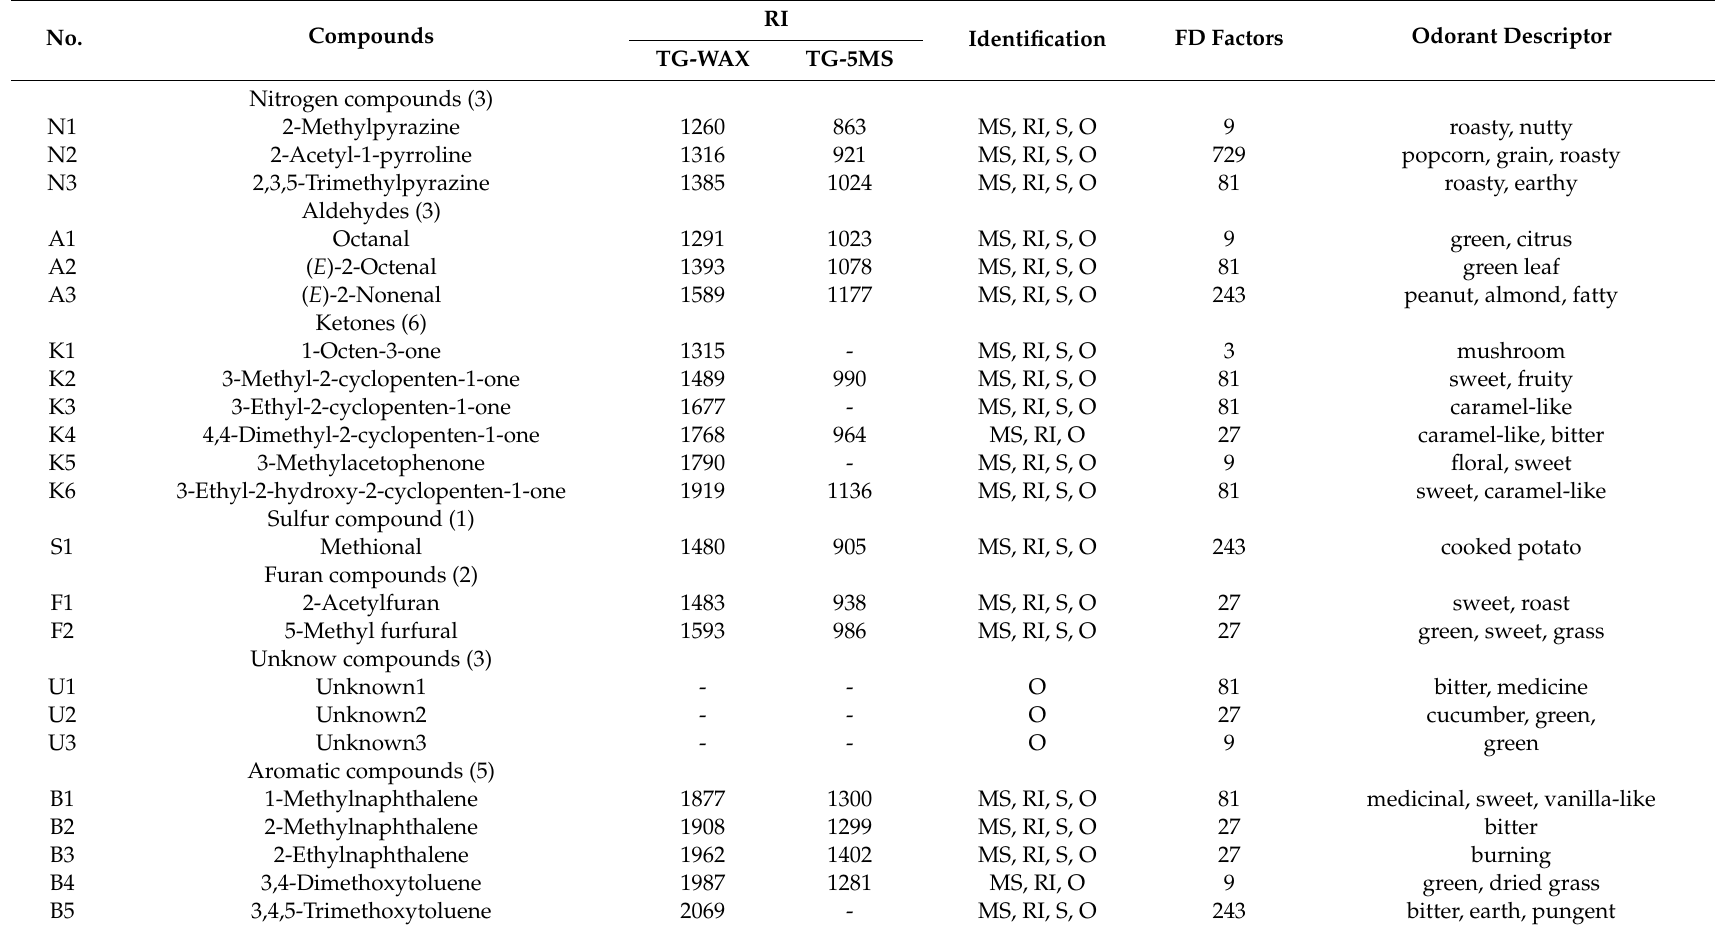
Table 2. Aroma-active compounds identified in traditional Hunan Smoke-cured Pork Leg (THSL) by gas chromatography–olfactory-mass spectrometry (GC–O–MS).